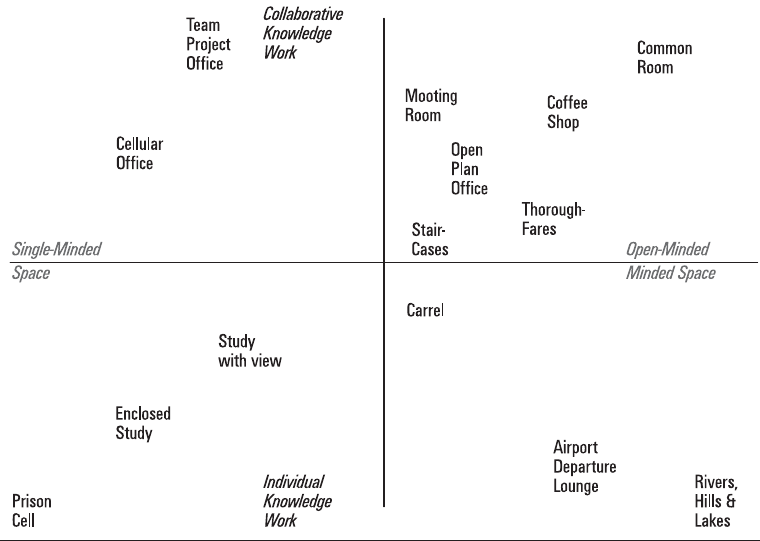
Figure 3. Knowledge-mind workspace